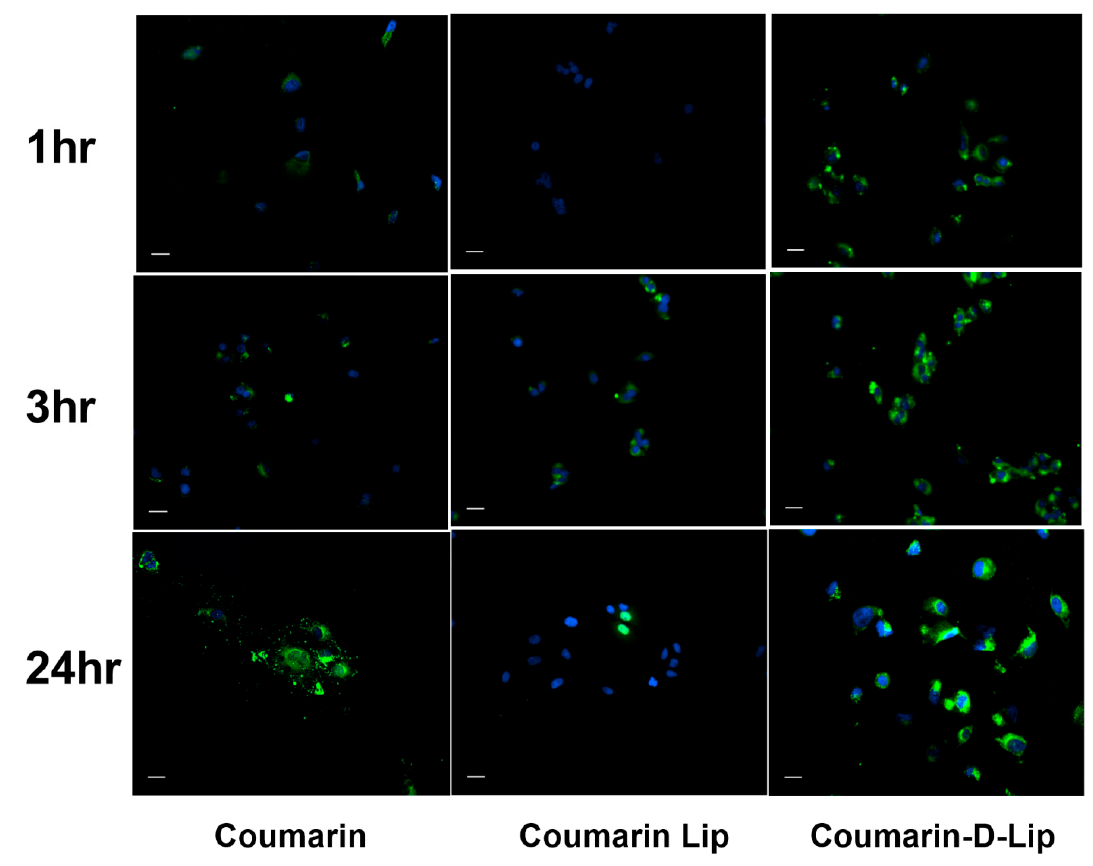
Figure 5. In-vitro cellular uptake of coumarin-6 loaded liposomes, with and without DOTAP in A549 cells at three di ff erent time points; 1, 3, and 24 hours. Coumarin-6 plain solution is used as control. Nuclei are stained blue (DAPI) and Coumarin–Lip and Coumarin–D-Lip are green. The highest internalization of Coumarin-loaded DOTAP liposomes was observed at 1, 3, and 24 hr time points compared to plain coumarin and coumarin liposomes. This indicated the importance of cationic charge in DOTAP liposomes in an e ffi cient cellular uptake. Scale bar 100 µ m. All experiments were performed in